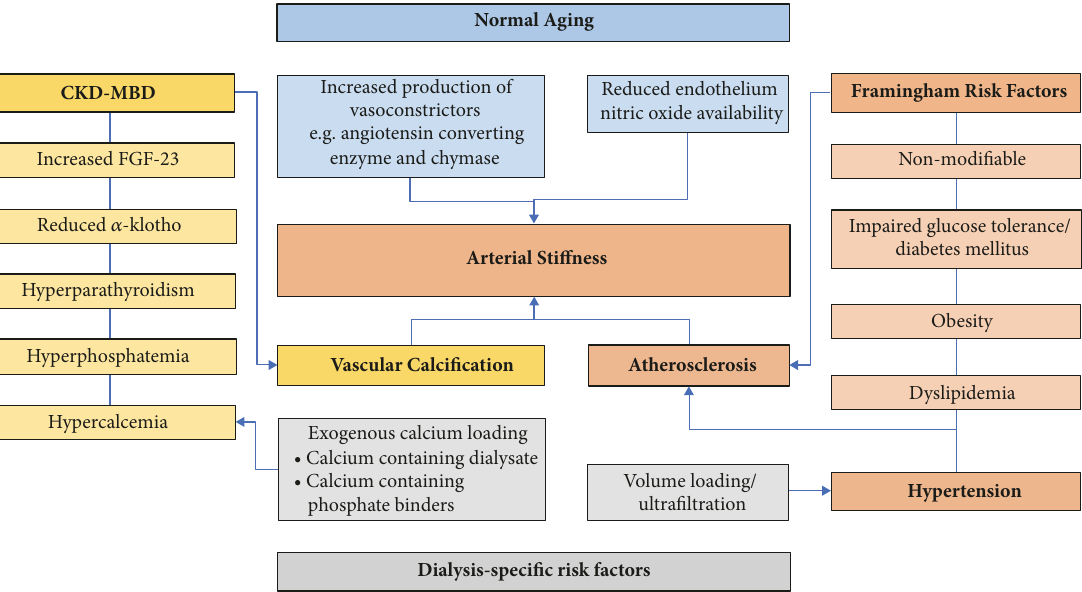
Figure 1: Pathophysiological factors contributing to arterial stiffness in patients with chronic kidney disease. A bb re v iations : CKD-MBD, Chronic Kidney Disease–Mineral Bone Disorder; FGF-23, fibroblast growth factor